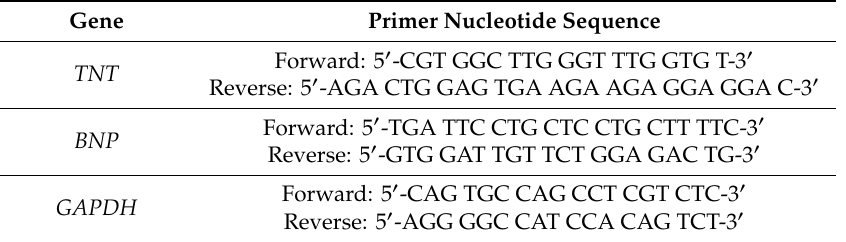
Table 1. Primers used in the real-time polymerase chain reaction